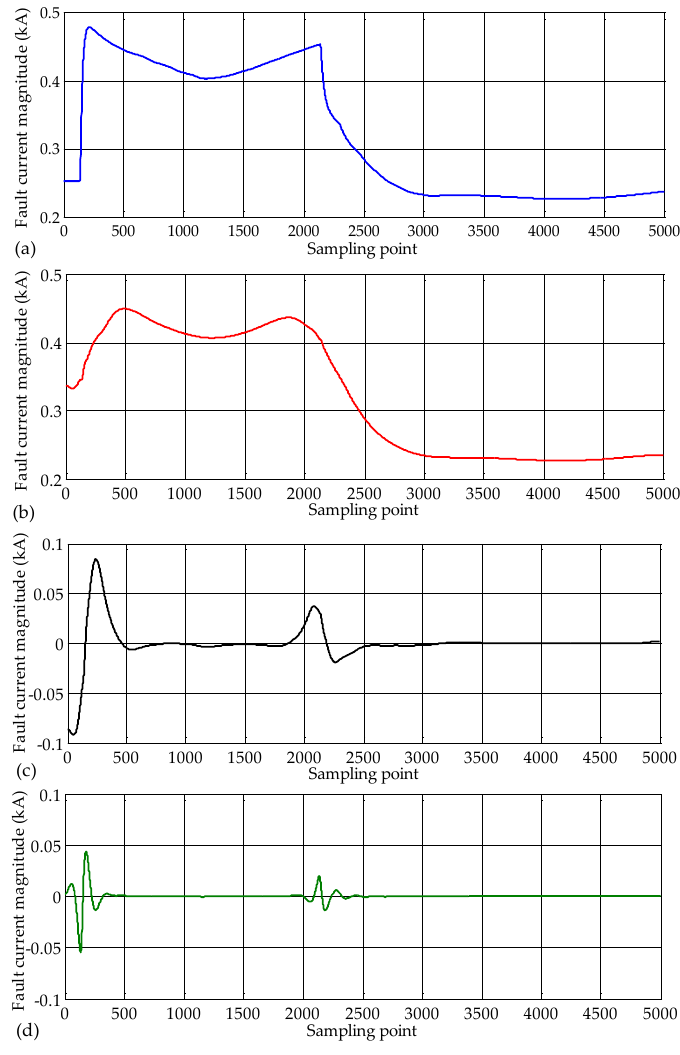
Figure 7. Analytical signal and its VMD results at terminal M: ( a ) The decoupled current mode 1 component; ( b ) The mode 1 component; ( c ) The mode 2 component; and ( d ) The mode 3 component.